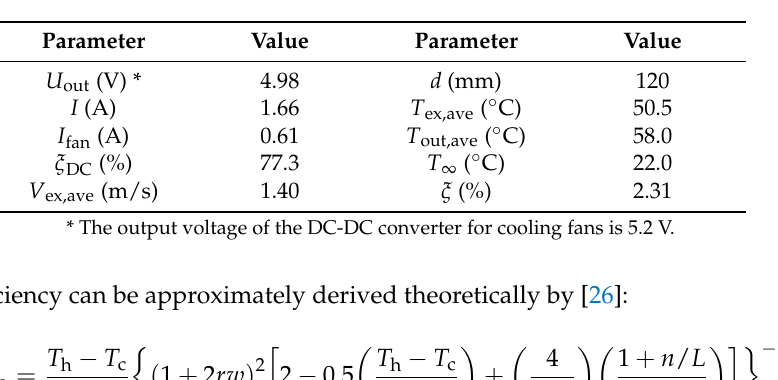
Table 2. The measured data of the flue gas.